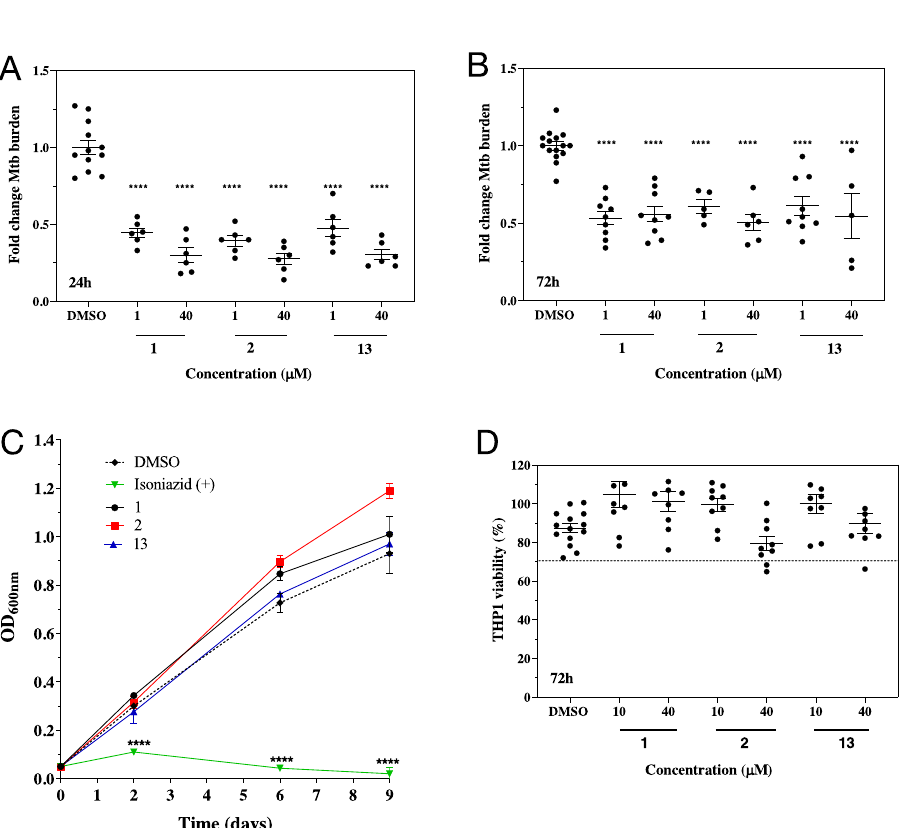
Figure 3. Effect of SapM inhibitors 1 , 2 and 13 on Mtb H37Rv growth and intracellular burden. Efficacy of compounds at 1 and 40 µM on Mtb intracellular burden in THP-1 macrophages at 24 h ( A ) and 72 h ( B ) post infection. Fold change of Mtb burden was calculated from the average CFU/ml relative to the DMSO control. Statistical significance was evaluated by one-way ANOVA (Dunnett’s test) compared to DMSO control (**** p < 0.0001). Error bars in ( A,B ) indicate ± SD of two and three independent experiments, respectively. ( C ) Effect of compounds at 40 µM on the acellular growth of Mtb in Middlebrook 7H9 broth monitored over 9 days using optical density (OD 600 ). DMSO and the first-line antibiotic isoniazid (at 0.14 µg/ml) were used as negative and positive controls, respectively. Error bars indicate ± SD of triplicates. Statistical significance was evaluated by two-way ANOVA (Dunnett’s test) compared to DMSO control (**** p < 0.0001). ( D ) THP-1 macrophage viability at 72 h upon treatment with compounds at 10 and 40 µM. Percentage of viability was calculated relative to the control (RPMI media only). Dashed black line indicates 70% viability. Error bars indicate ± SD of three independent